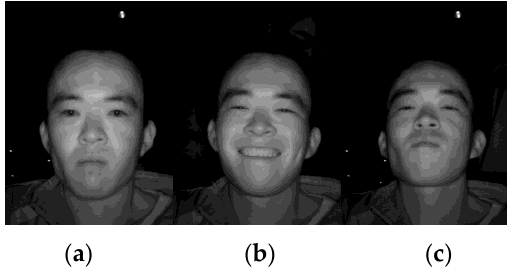
Figure 4. NIR pictures of one person under normal ( a ), expression variation ( b ) and head pose variation ( c ) conditions.